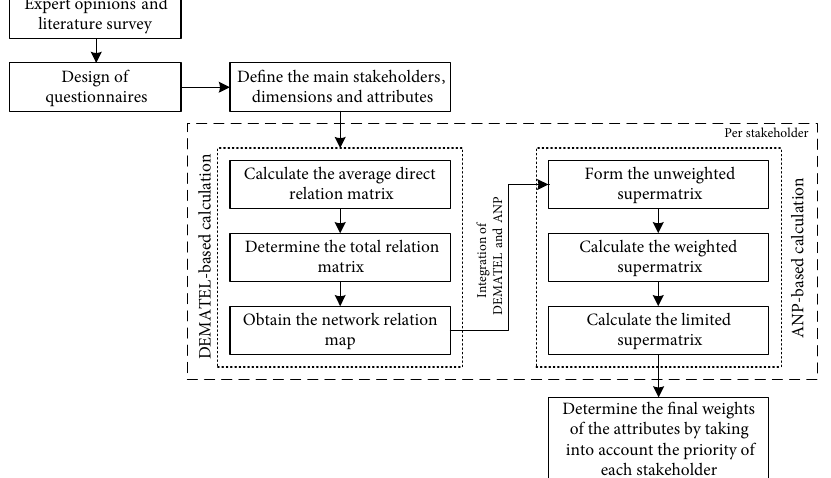
Figure 4. A general overview of the evaluation framework